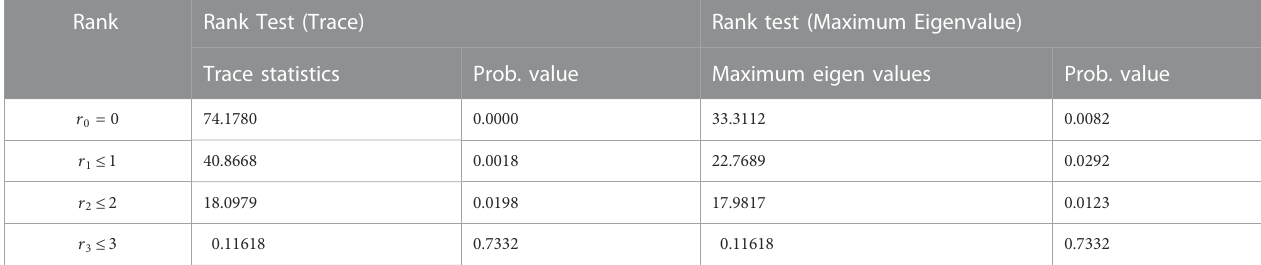
TABLE 2 Johansen Cointegration Test. Rank